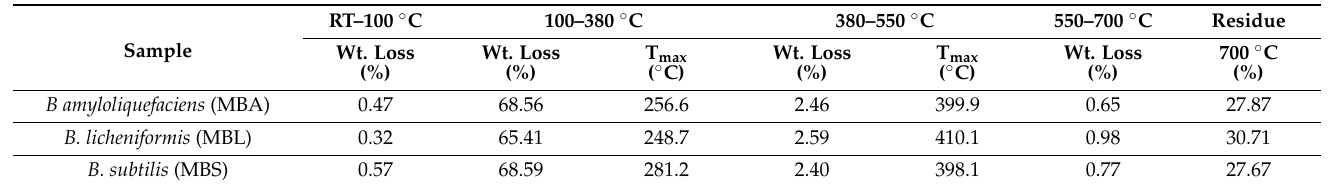
Table 3. Results of TGA analysis applied to deposit samples from bacterial cultivation on medium without urea and Ca 2+